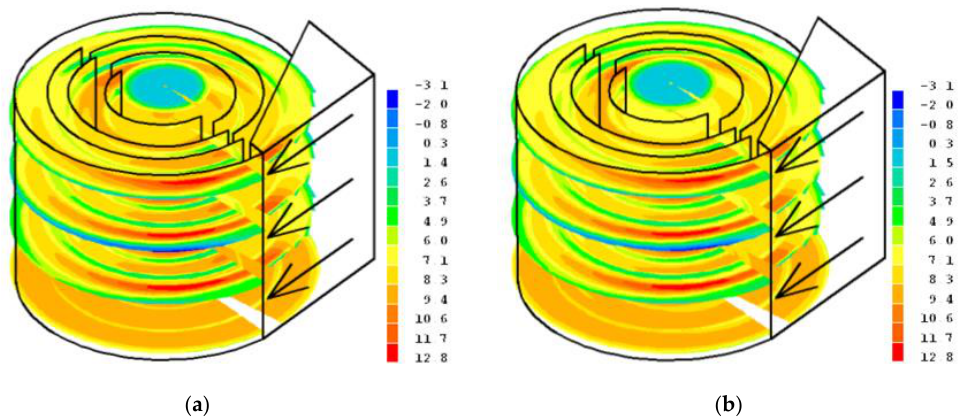
Figure 3. The gas (air) flow (first phase ( a ) and second phase ( b )) velocity components ’ distribution in the six-channel cyclone structure using median- diameter (8.995 μm) glass particulate matter at a 9.3 m/s inlet velocity in the cyclone.